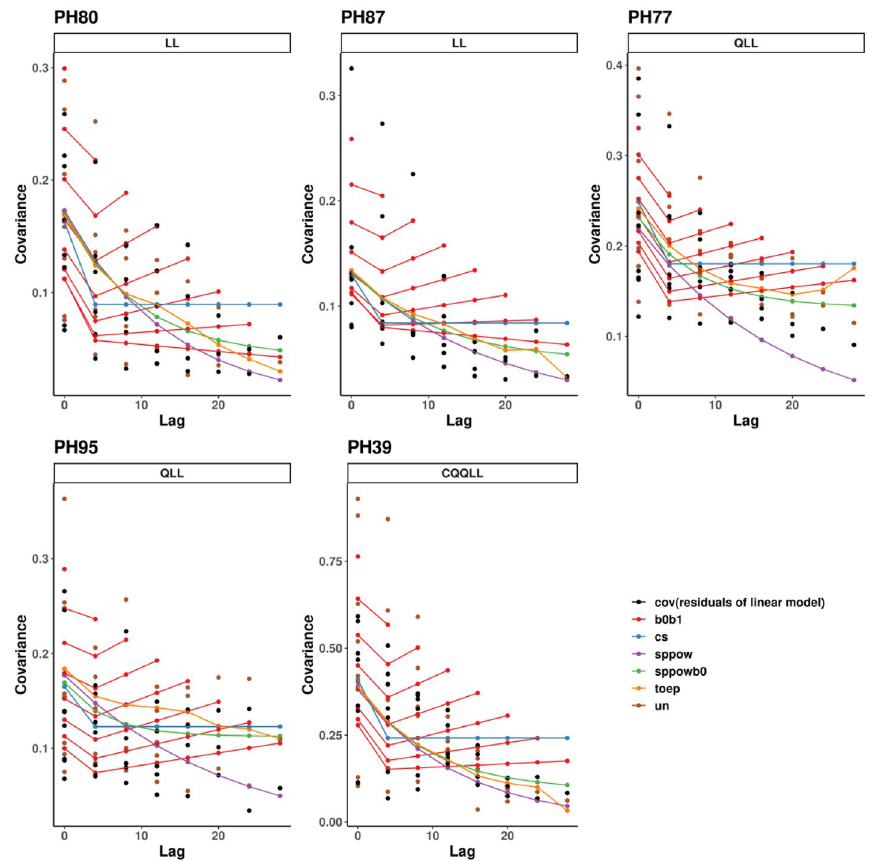
Figure 2. Covariance structures. Overlaid observed and estimated covariance structures for each PDX model with the chosen mean model. The x-axis is the lag (or distance in time) between two observations. The y-axis is variance (at lag 0) and covariance (at lags greater than 0). Covariance estimates based on ML independence model residuals are indicated with black dots. The remaining structures are estimated via REML. Unstructured estimates are indicated with brown dots, except for PH87 where this model did not converge. An unstructured (UN) covariance matrix imposes no restrictions or assumptions, allowing estimation of separate variance and covariance parameters between all possible pairs of time points, thus requiring many parameters, and making inefficient use of available data. RE (labeled b0b1) estimates are indicated by multiple red lines due to the dependence of the variance and covariance on both lag and the precise point in time. Sp(pow) assumes the covariance declines smoothly to 0, demonstrated by the purple lines tapering to near 0 by lag 28. Similarly, the sp(pow) + RE (labeled sppowb0) assumes the covariance tapers smoothly to the between mouse variance (the random effect). CS assumes the same covariance regardless of lag as seen by the flat line for lags 1 and greater; the taper in the unstructured points do not support this assumption. The Toep estimates generally decrease as lag increases, but not as quickly or smoothly as the sp(pow) or sp(pow) + RE, and for PH77 increases toward the end of the study. The fact that sp(pow), sp(pow) + RE and Toep depend only on lag and not actual study time is evident from one point at each lag. All of these traits can be observed in the printed variance estimates as well (Supplemental Table